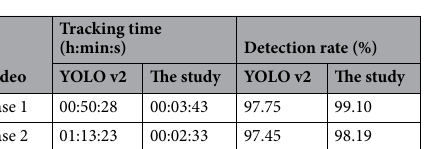
Table 2. Performance comparison between this proposal and a YOLO v2